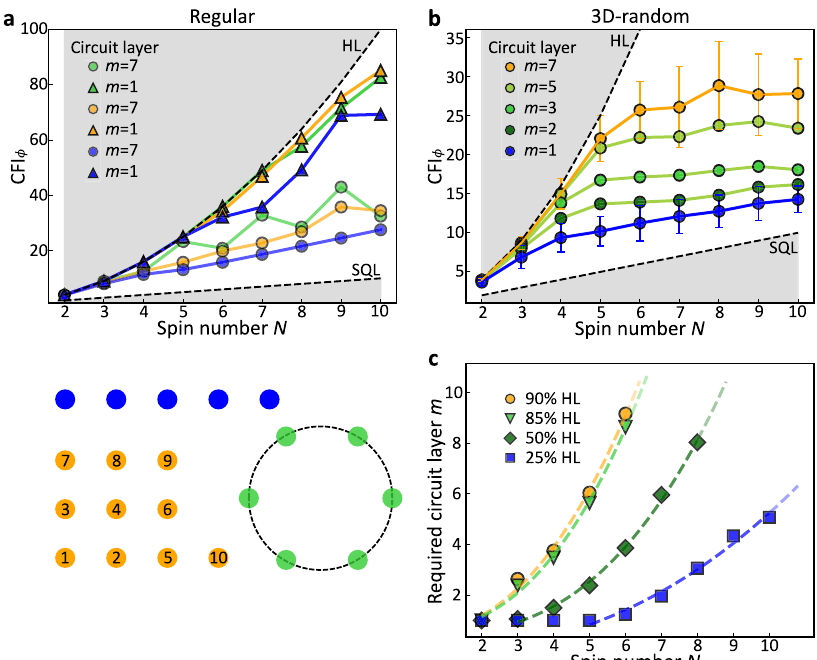
Fig. 2 Optimization results of different spin con fi gurations. a Top: CFI for m = 1 (circles) and m = 7 (squares) circuits. The colors correspond to the con fi gurations shown below. Bottom: schematics of different spin con fi gurations. The numbers in the 2D square lattice pattern label the order in which spins are added to form a lattice of size N . b Average CFI for 50 con fi gurations of 3D-randomly distributed spins. Error bars stand for the standard deviations of the optimized CFI from different spin con fi gurations. (Error bars for m = 2, 3, 5 are omitted for clear presentation). c Average number of layers required to achieve a CFI within a given percentage of the HL in the case of 3D-random con fi guration. The fi t m = aN b + c with b = 2.45 (goodness of fi t R 2 = 0.996) serve as a guide to the eye. The same data also fi ts to an exponential model with slightly lower R 2 = 0.995. The investigation of deeper circuits becomes increasingly challenging as the ef fi ciency of the employed optimization algorithm steeply decreases for m > 9. See Supplementary Figs. 2,5,6 and Supplementary Methods for more